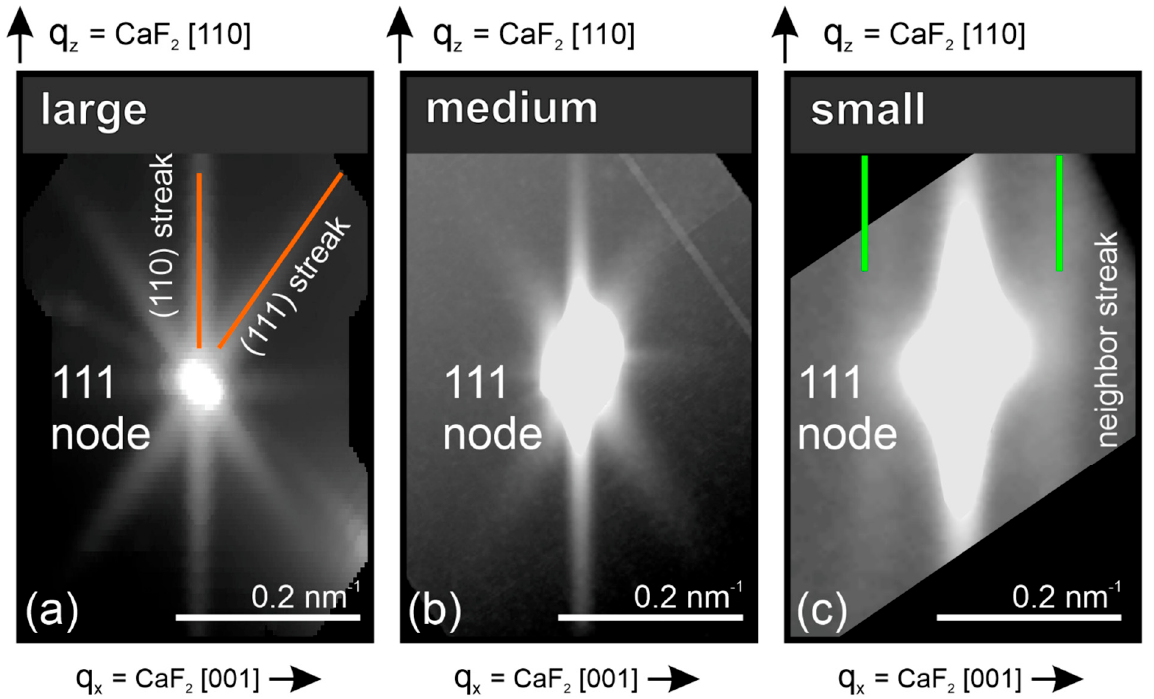
Figure 3. XRD maps obtained in CaF 2 /Si(001) samples with large ( a ), medium ( b ) and small ( c ) stripes. The maps represent projections of reciprocal space around the CaF 2 (111) off-specular reflection along the CaF 2 [1–10] direction parallel to the stripes. The diffuse scattering shows pronounced streaking corresponding to the {111} side and (110) bottom facet. The facet streaks get less pronounced as the stripes become smaller. Also present on the sample with small stripes are vertical nearest neighbor streaks. Axis q z is perpendicular to the substrate surface, and axis q x is perpendicular to the stripes.